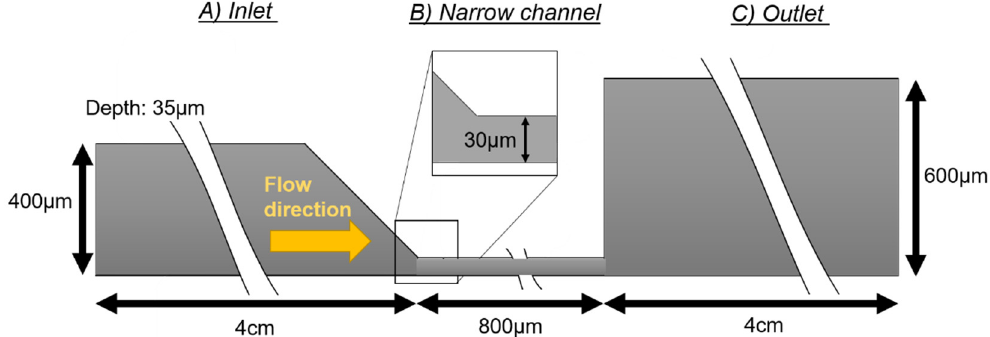
Figure 1. The figure represents the geometry of the microfluidic channel, with a constant depth of 35 μ m. The length of the ( A ) inlet section is 4 cm long and 40 μ m wide. The ( B ) narrow channel is 30 μ m wide and 800 μ m long. The ( C ) outlet section is 4 cm long and 600 μ m